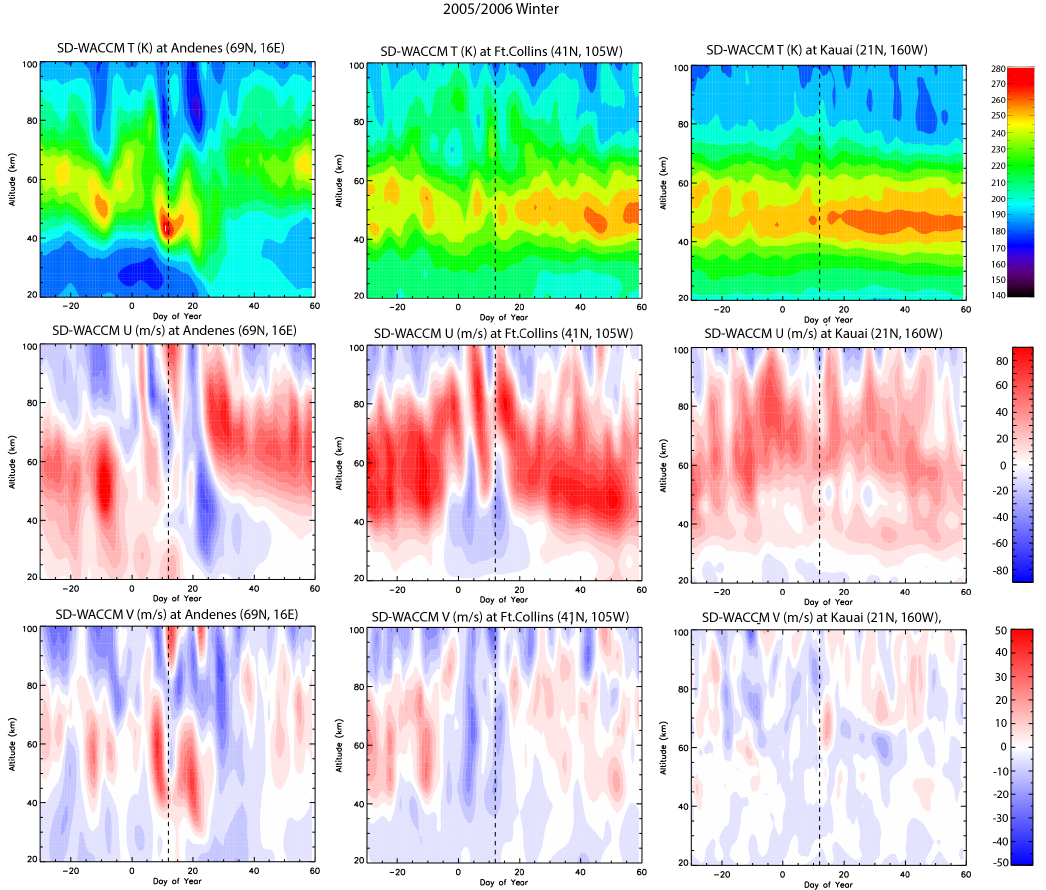
Figure 9. The temperature (top panel), zonal-mean zonal wind (middle panel) and mean meridional wind (bottom panel) from the WACCM at grid points closest to Andenes (69 ◦ N, 16 ◦ E), Fort Collins (41 ◦ N, 105 ◦ W) and Kauai (21 ◦ N, 160 ◦ W) from left to right during the 2005–2006 northern hemispheric winter. The dotted line indicates the day of peak warming (12 January) over the polar